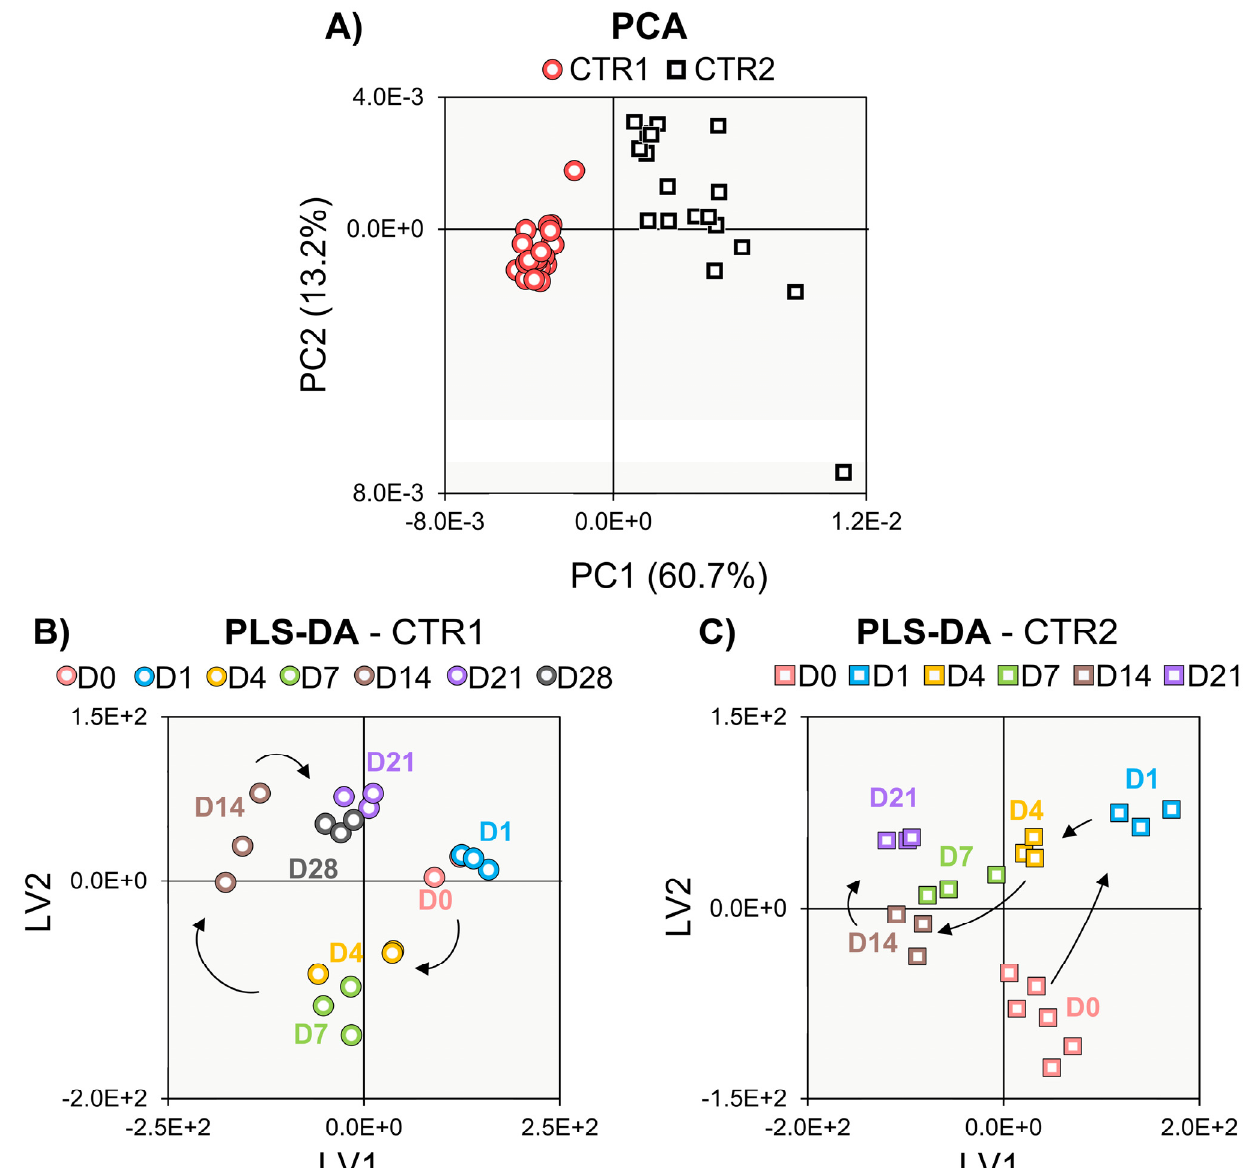
Figure 2. Multivariate analysis of 1 H NMR spectra of polar extracts of proliferating hAMSCs of donors 1 (circles) and 2 (squares). Scores scatter plots of ( A ) PCA for donors 1 (red) and 2 (black), and PLS-DA for donors 1 ( B ) and 2 ( C ). CTRi, control hAMSCs for donor i; Di, day i; LV, latent variables; PC, principal component.